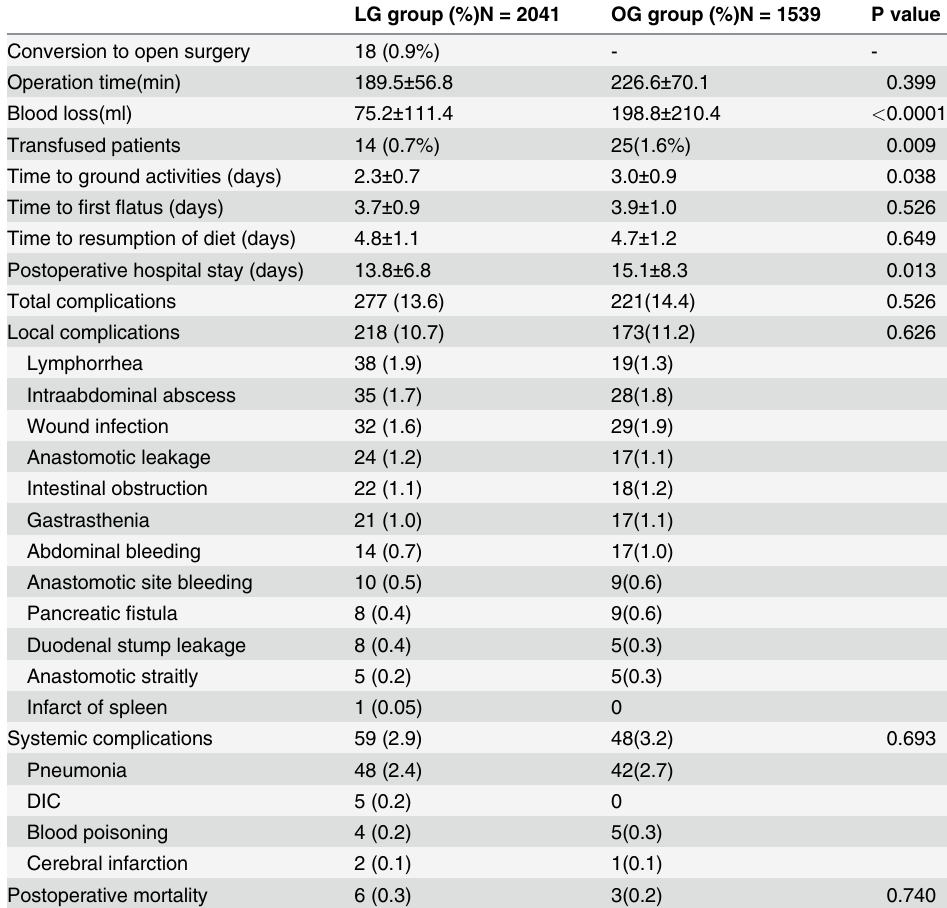
Table 2. Perioperative and postoperative results after laparoscopic and open